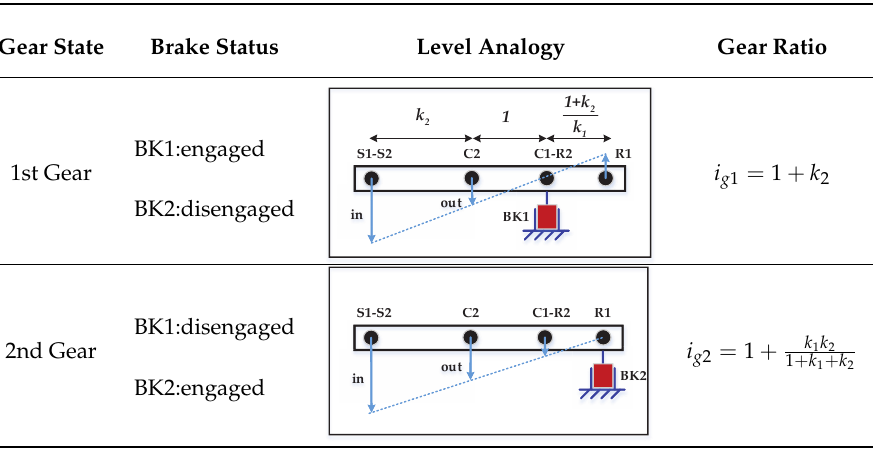
Figure 1. Layout of the two-speed transmission drivetrain: ( a ) Diagram of the electric power-train; ( b ) Cross-sectional view of the virtual prototype of the electric power-train (EM—Electric motor; BK1—First gear brake assembly; R1—First ring gear; C1—First carrier; S1—First sun gear; P1—First planet gears; BK2—Second gear brake assembly; R2—Second ring gear; C2—Second carrier; S2—Second sun gears; P2—Second planet gears). Table 1. Gear states for the two-speed